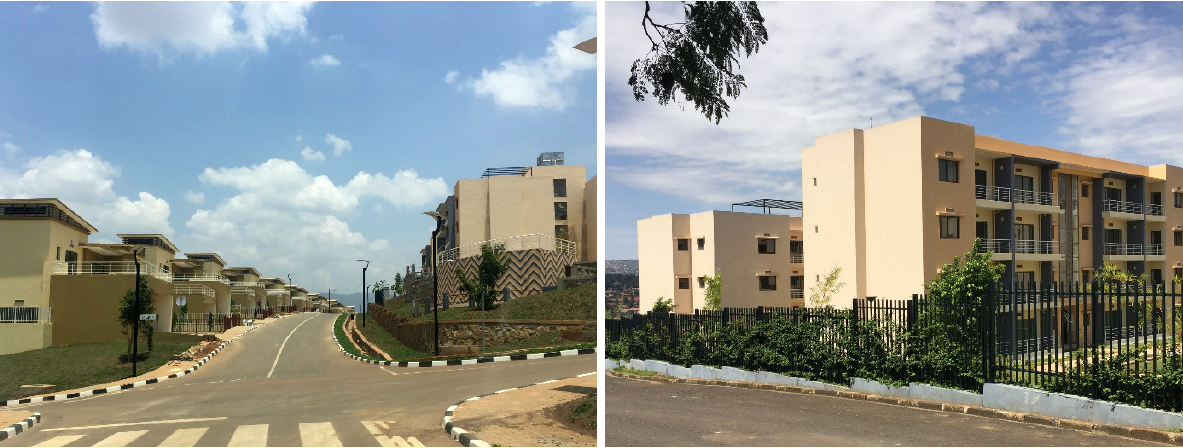
Figure 60. The Umudugudu Kigali Vision: Condominium (2-4 bedrooms). Photograph by Manlio